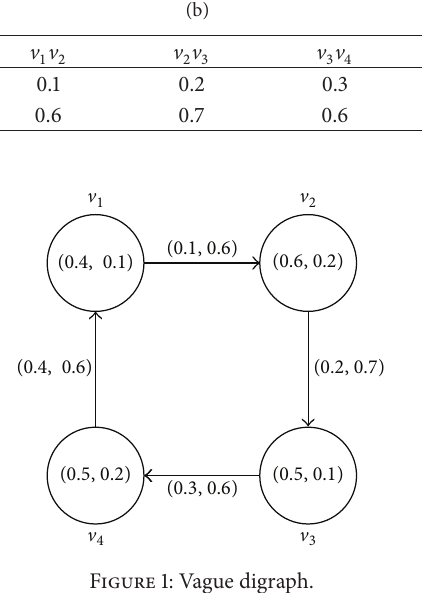
Figure 1: Vague digraph.